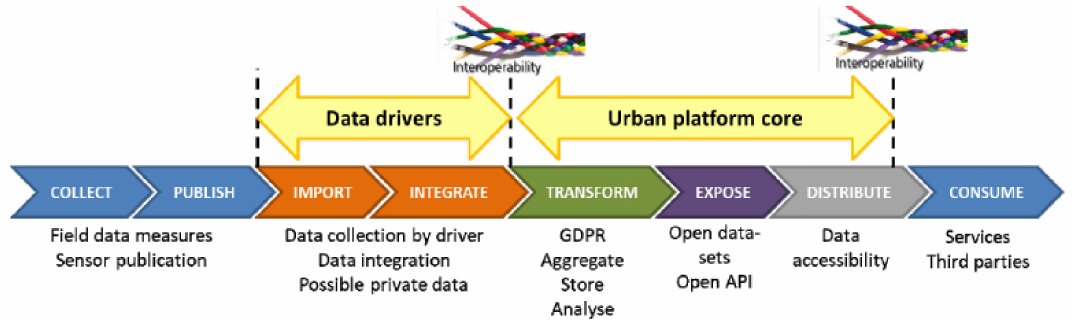
Figure 4. Data management procedure defined within